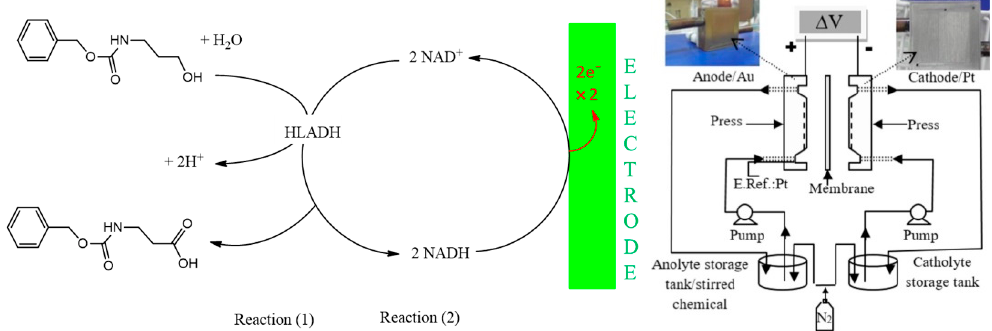
Figure 8. Schematic diagram of an electrochemical microreactor system and the electroenzymatic oxidation of carboxybenzyl- β -amino propanol. Reprinted from [145]. Copyright (2020), with permission from Elsevier.